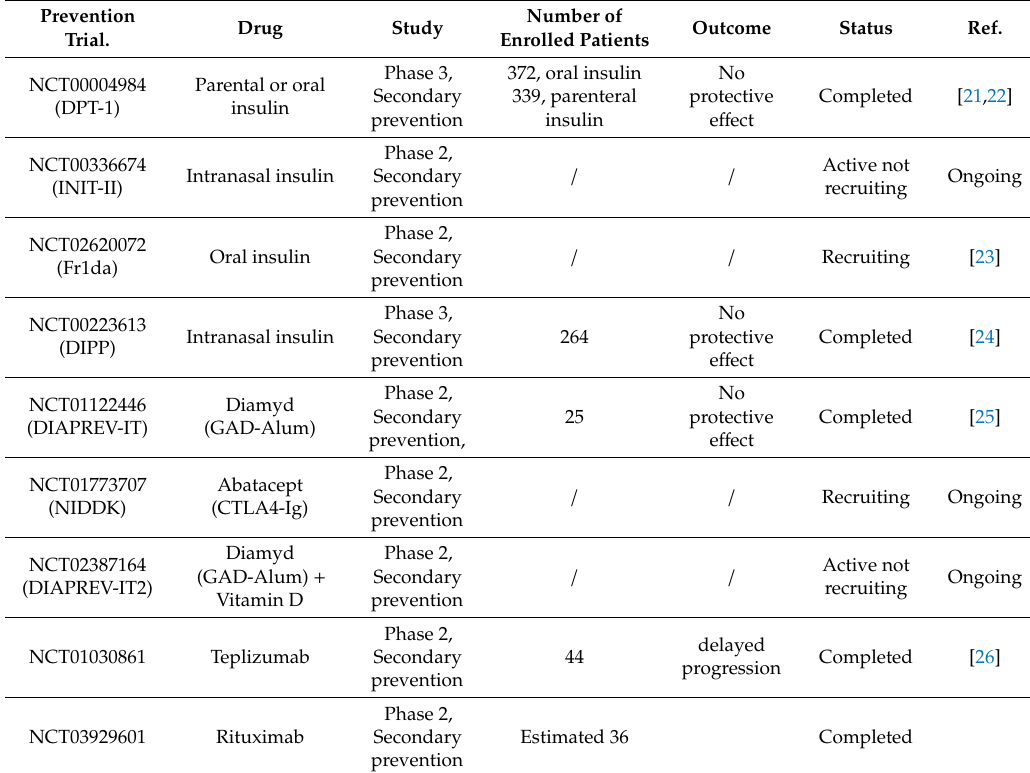
Table 1. Trials at type 1 diabetes (T1D) stage 1.